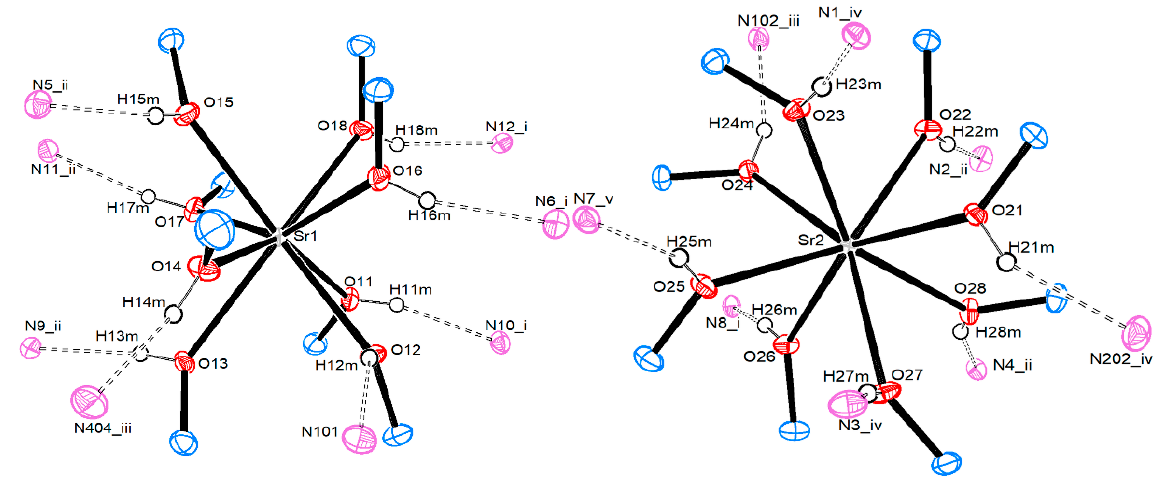
Figure 10 . The first and second coordination spheres of the Sr 2+ ions in compound 3 .